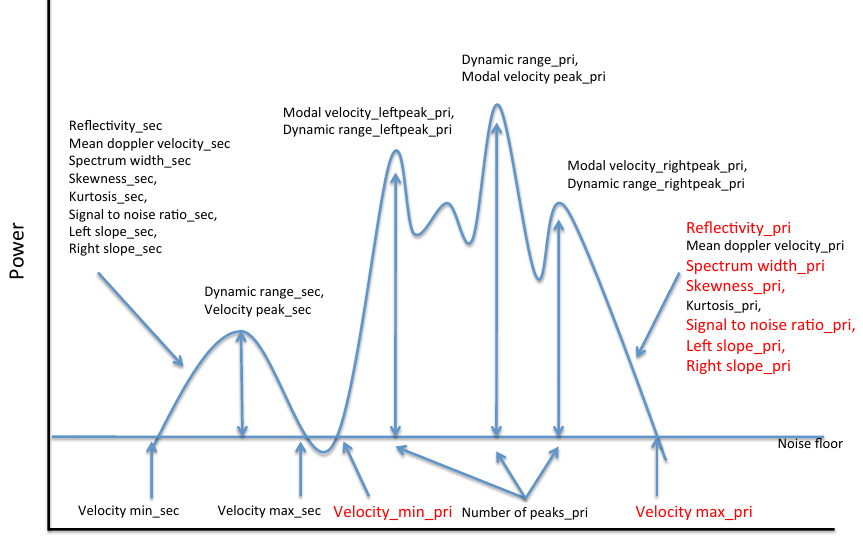
Figure 1. Schematic of Doppler spectrum and MicroARSCL variables. Variables describing the primary peak ( ∗ _pri) and a secondary peak ( ∗ _sec) are labeled in the diagram. The variables used in this study are shown in red. Each radar time and height bin measured by the vertically pointing instrument returns a full spectrum of Doppler velocities.